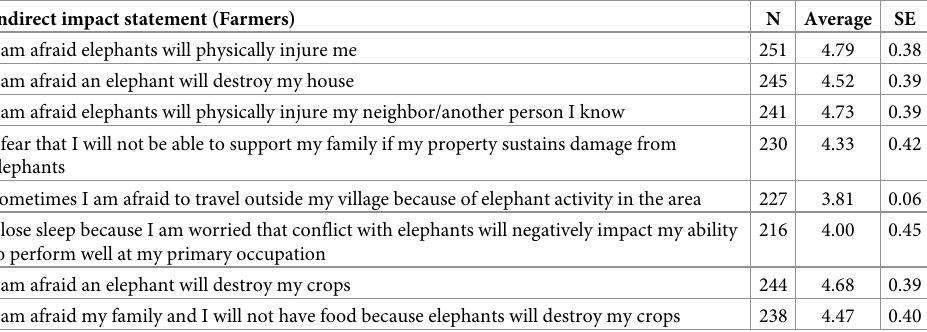
Table 5. Indirect impacts experienced by farmers (n = 278) and used to create a farmer specific indirect impact scale in the Bago-Yangon and Ayeyarwady regions of Myanmar (May 2017-December 2018). Indirect impact statement